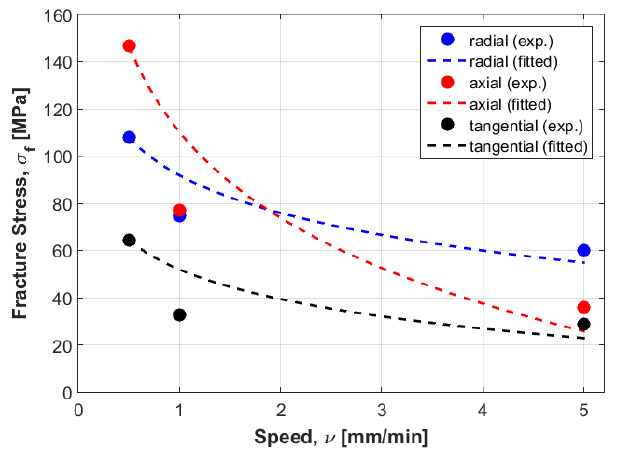
Figure 3. Experimental fracture stress in dots and curve fitting of the three directions at the three displacement rate